Question: Author a descriptive caption for the visualization shown.
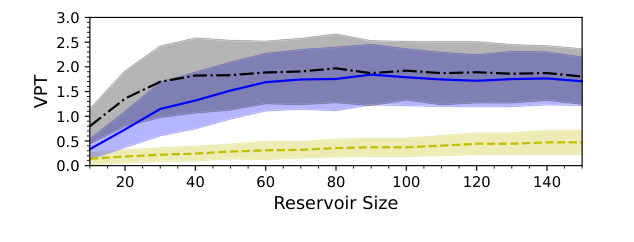
Answer: (a) NRMSE and (b) VPT for classical linear regression (dashed orange line), linear attention (solid blue line), and nonlinear attention-enhanced reservoir computing (dashed-dotted black line) with varying reservoir size N for UCTLS with a forcing strength of zero, essentially making it a classic single Lorenz task. The shaded areas depict the standard deviations of NRMSE and VPT over ten time series.